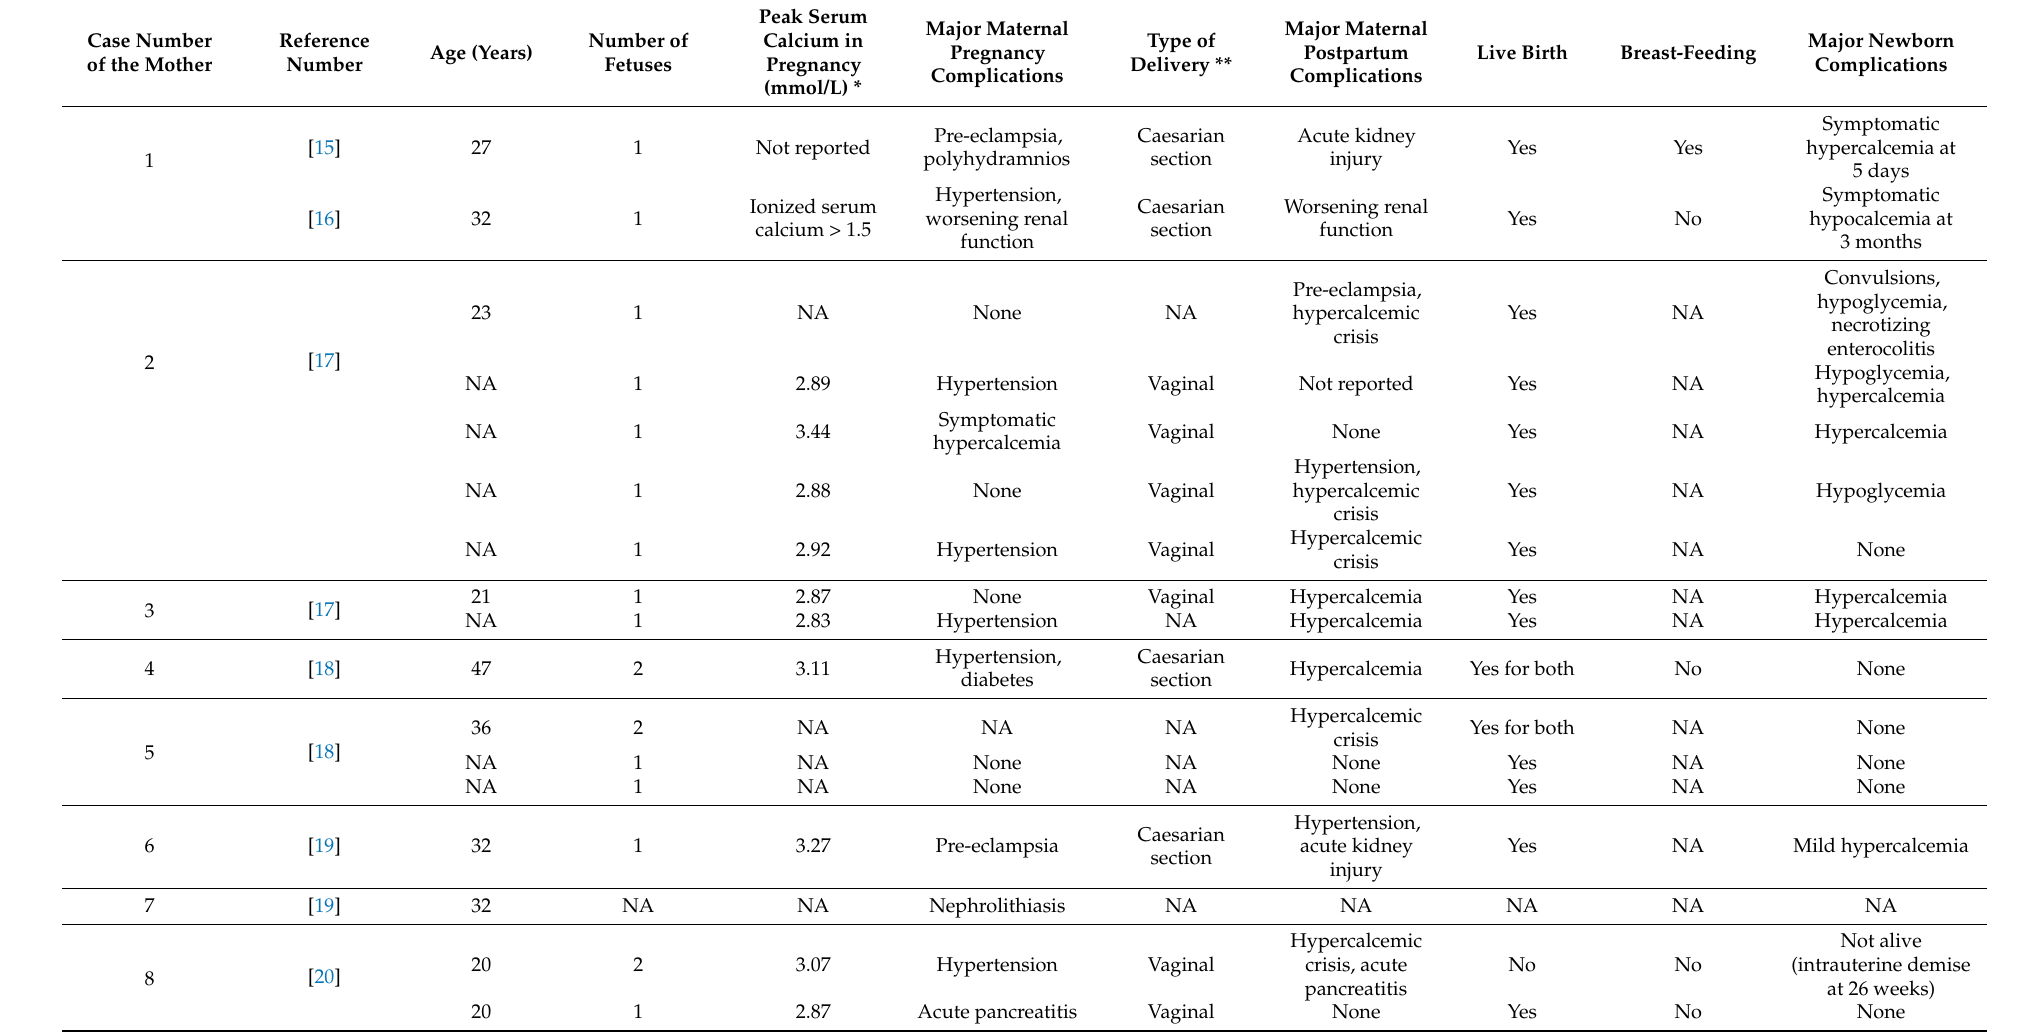
Table 2. Characteristics of pregnancies of women with pathogenic CYP24A1